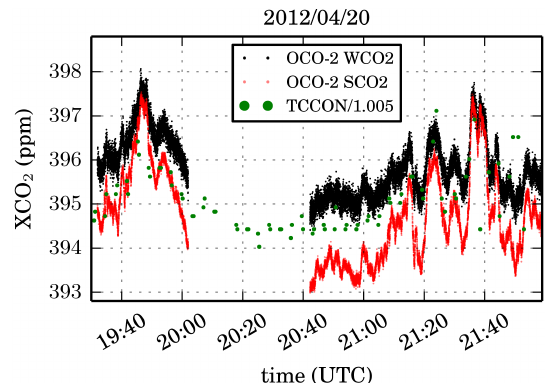
Figure 13. Zoom on the CO 2 column time series on 20 April 2012 acquired at JPL. Every OCO-2 data point is plotted and all eight footprints are